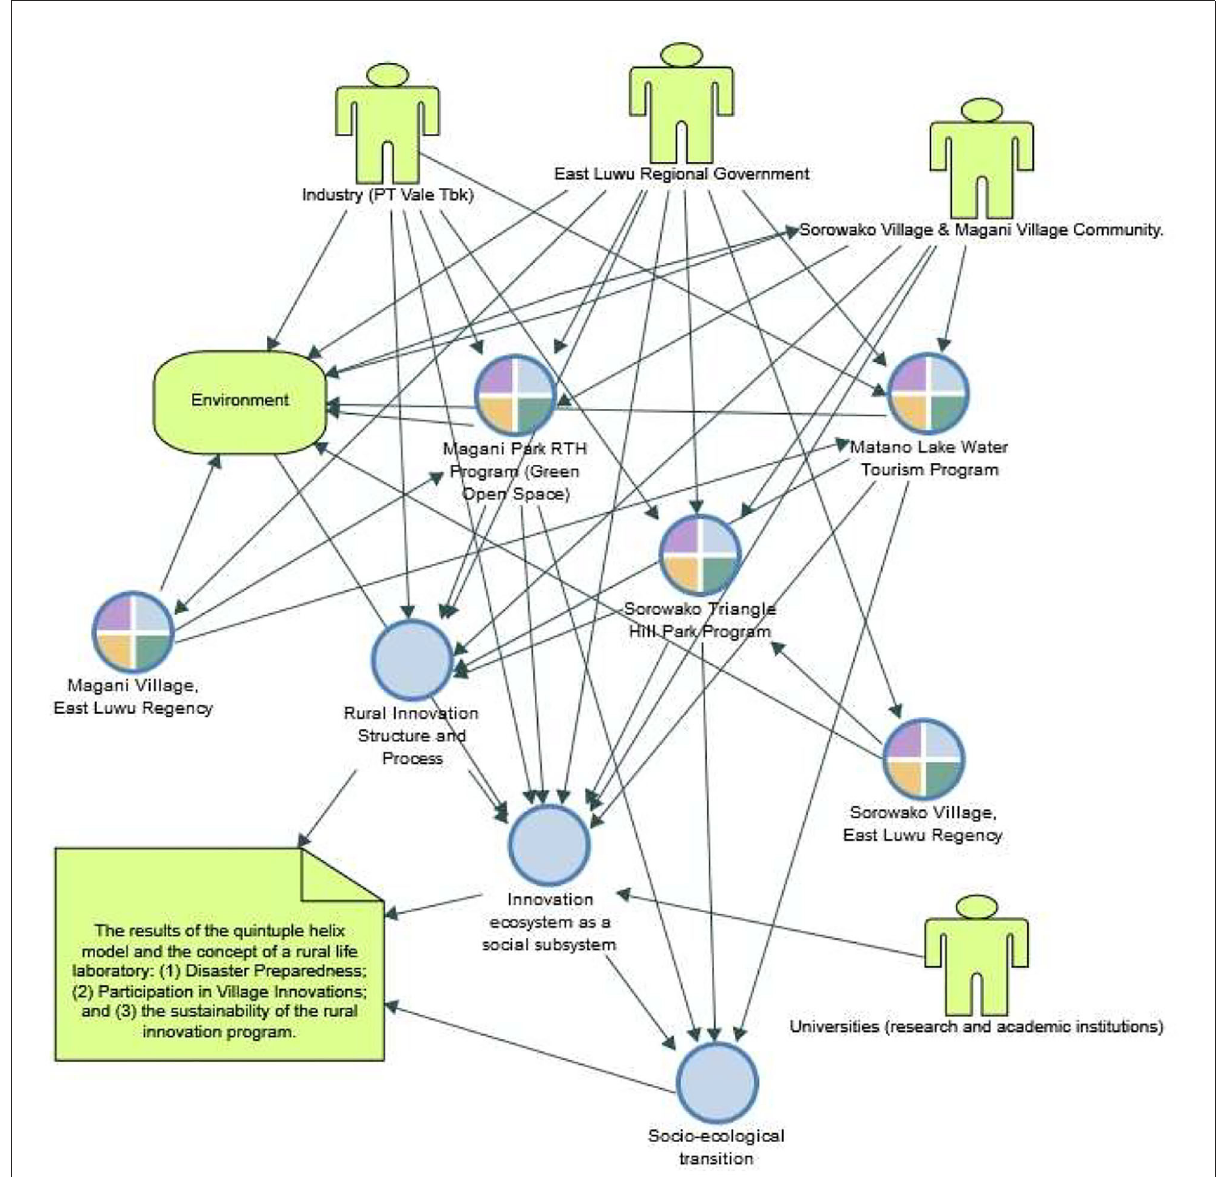
FIGURE4 Maps of program-based Quintuple Helix innovation and collaboration in Sorowako and Magani Villages, East Luwu Regency. Source: Processed from Nvivo 12 Pro